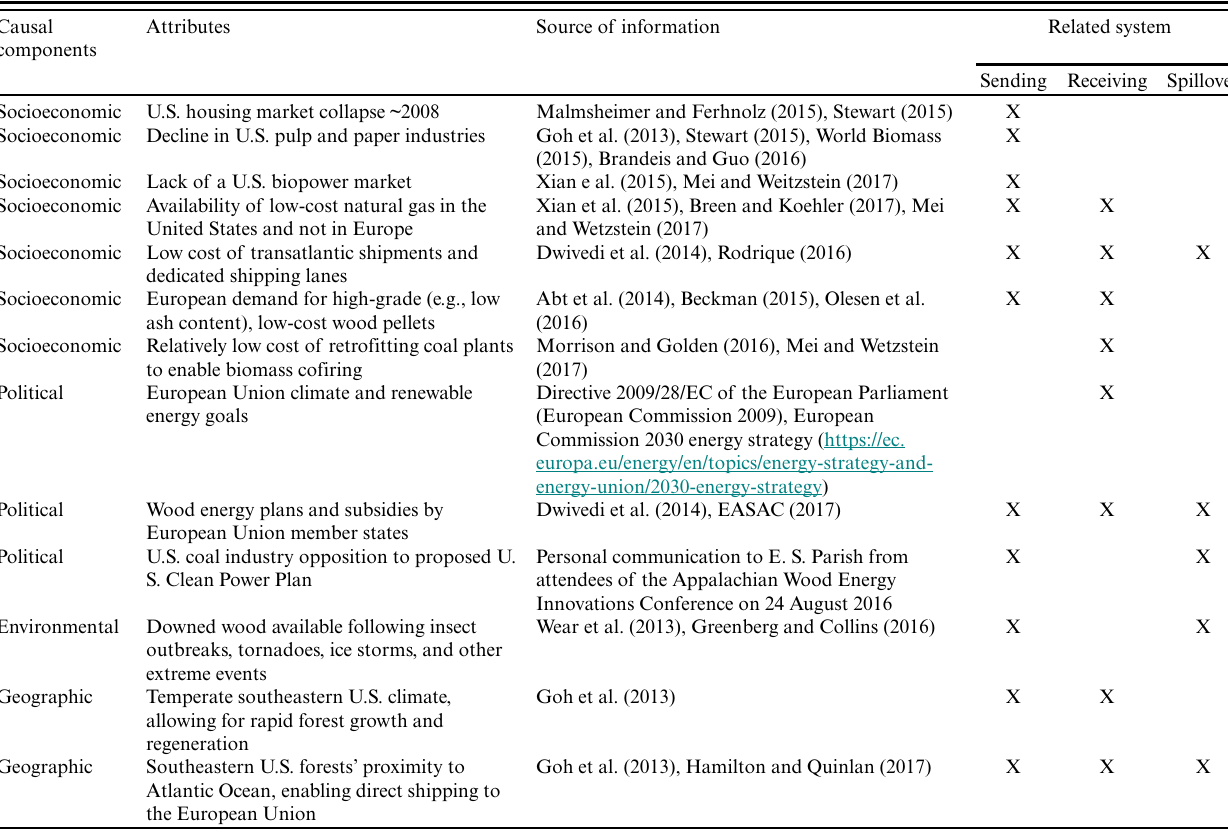
Table 3. Causal components of the telecoupled transatlantic wood pellet trade system. Xs indicate the systems (Table 1) that are most closely related to each component